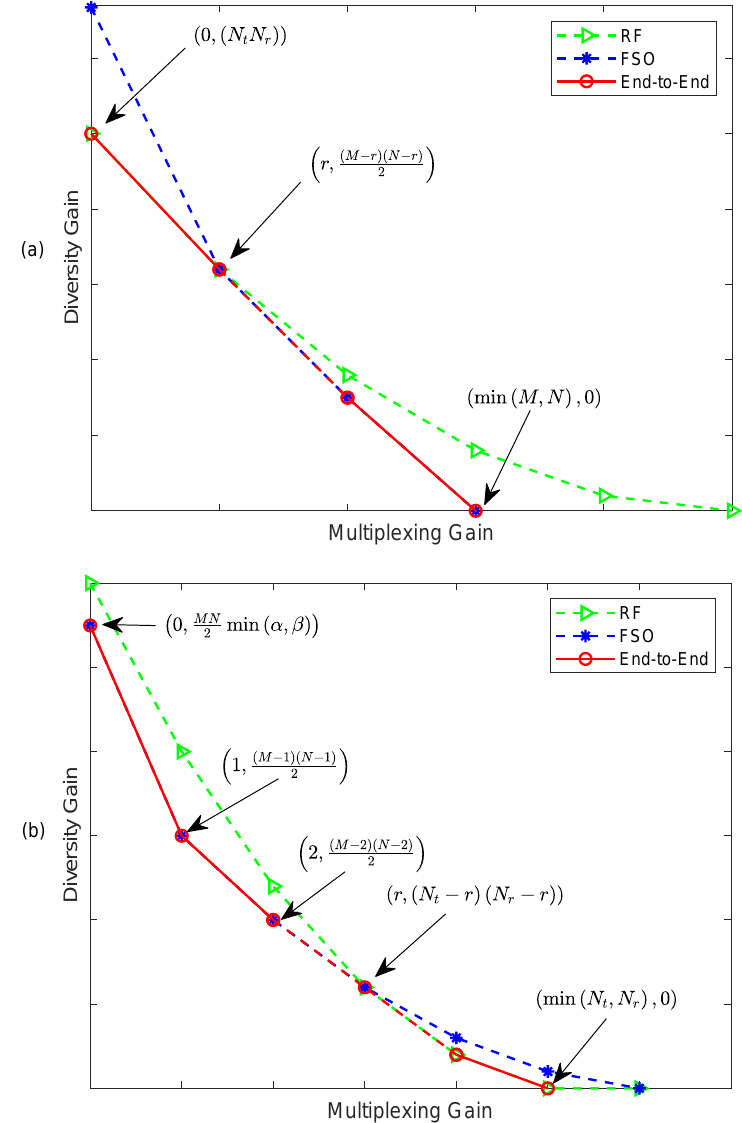
Figure 9. DMT of MIMO mixed RF/FSO system with intersection. ( a ) RF link dominates maximum diversity gain; ( b ) FSO link dominates maximum diversity